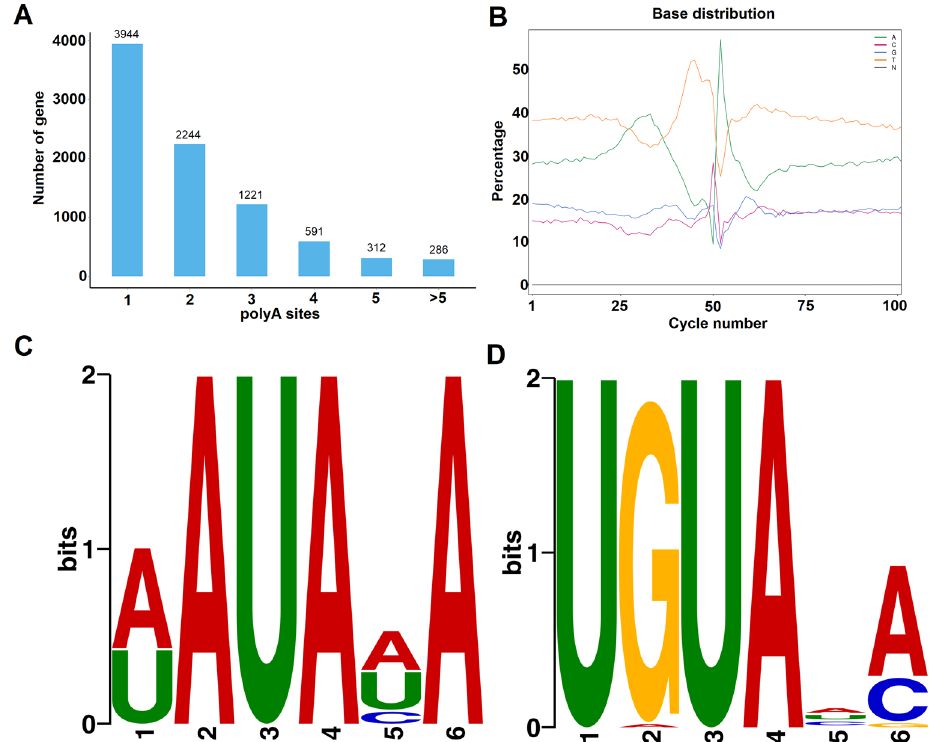
Figure 4. Characteristics of APA events in Prunus persica . ( A ) Distribution of polyadenylation sites per gene. ( B ) nucleotide composition around poly ( A ) cleavage sites. A signal motif identified by MEME suite at about 25 nts ( C ) and 35 nts ( D ) upstream of the poly ( A ) sites in Prunus persica transcripts.